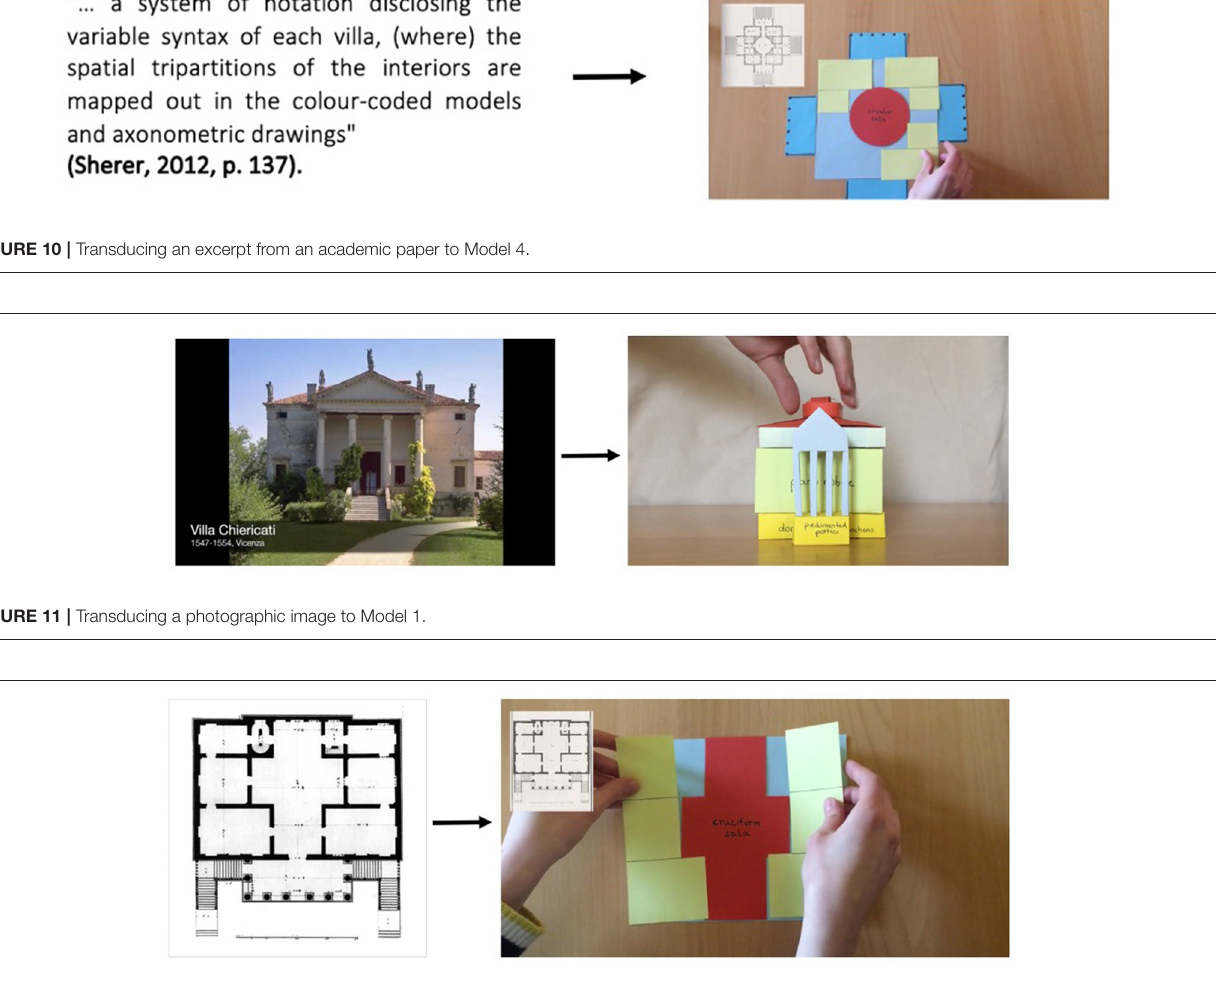
FIGURE 12 | Transducing a diagram to Model